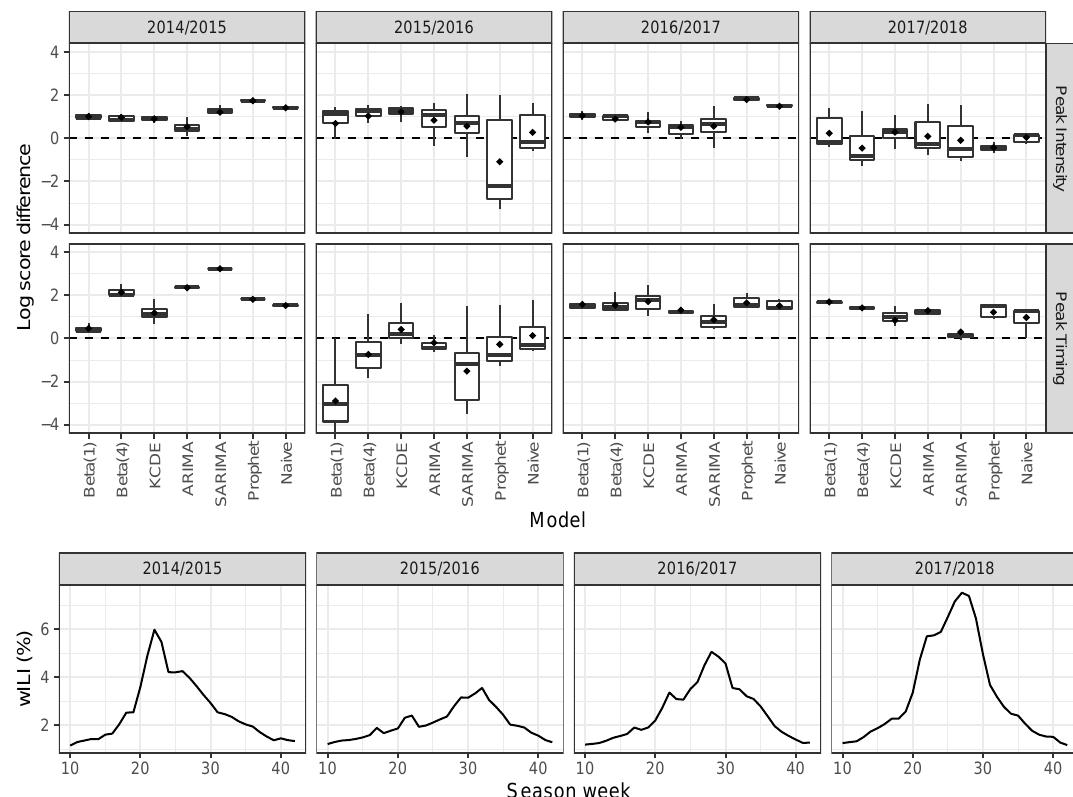
Figure 4. Each boxplot (top) summarizes predictions made by a model in the subset “before peak.” The vertical axis is the difference in log score between the given model and the equal-bin approach. Positive values favor the model over the equal-bin approach. The mean is indicated by dots. The bottom plot shows the epidemic curve for each